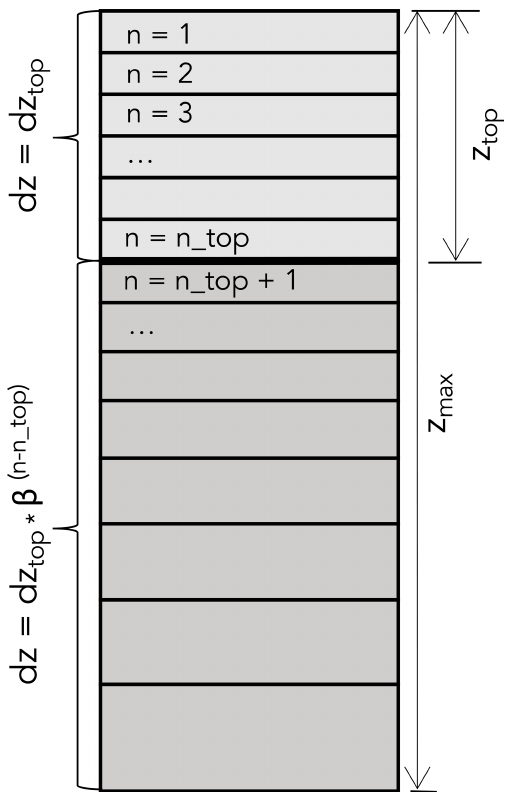
Figure 1. Diagram showing the model layer initialization as de- scribed in Sect. 2.1: d z is the layer thickness, d z top is the maximum near-surface layer thickness, z top is the depth of the near-surface, z max is the maximum column depth, β is a unitless scaling by depth parameter, and n is the layer